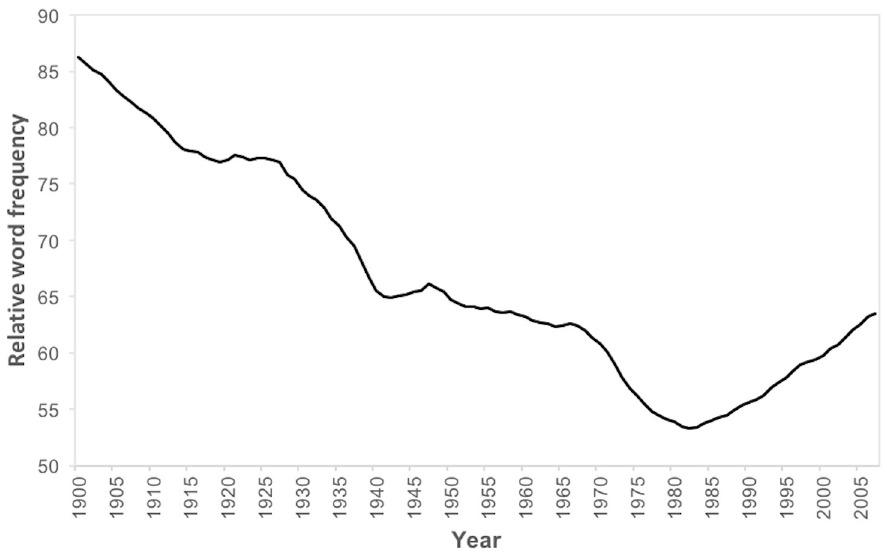
Fig 1. Time series of the general morality dictionary from 1900 to